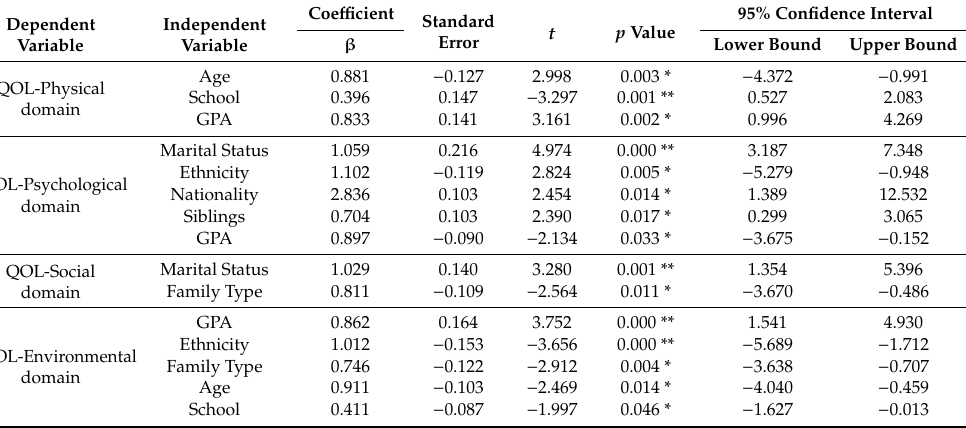
Table 5. Summary of stepwise regression analysis for variables predicting physical, psychological, social and environmental domains (N =